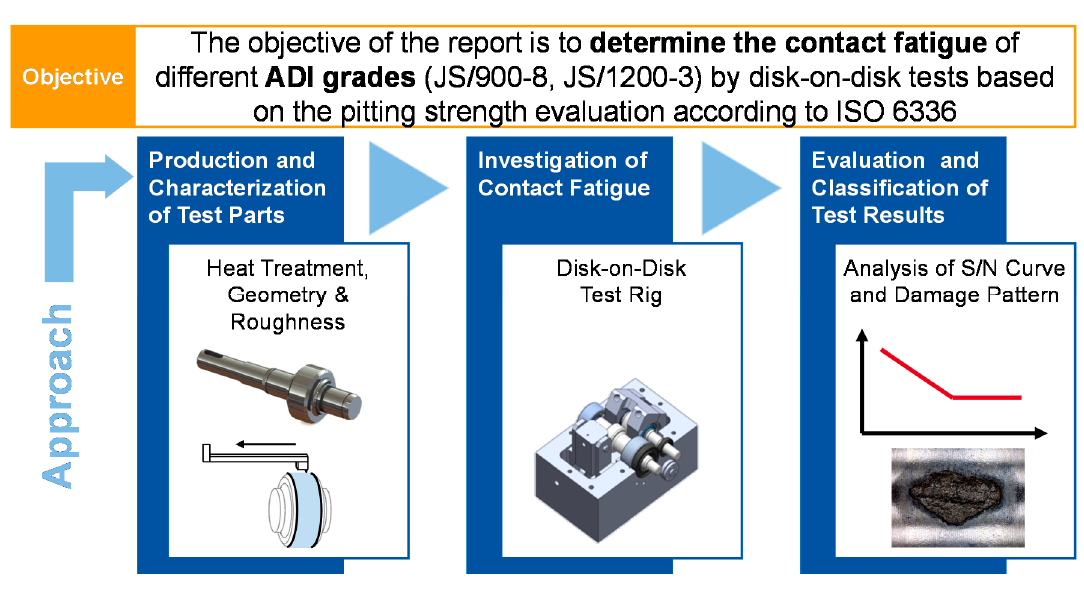
Table 1. Chemical composition of the casting